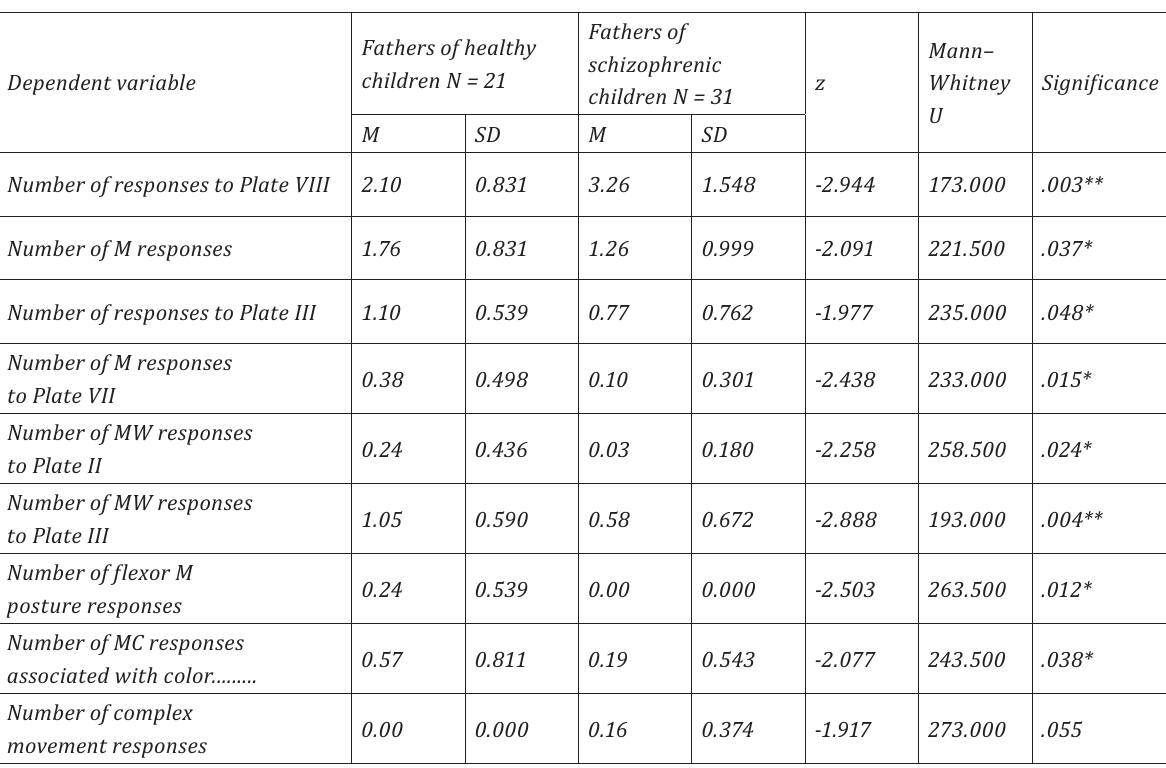
Table 4. Differences and the significance of differences in terms of selected variables between the group of fathers of healthy children and the group of fathers of